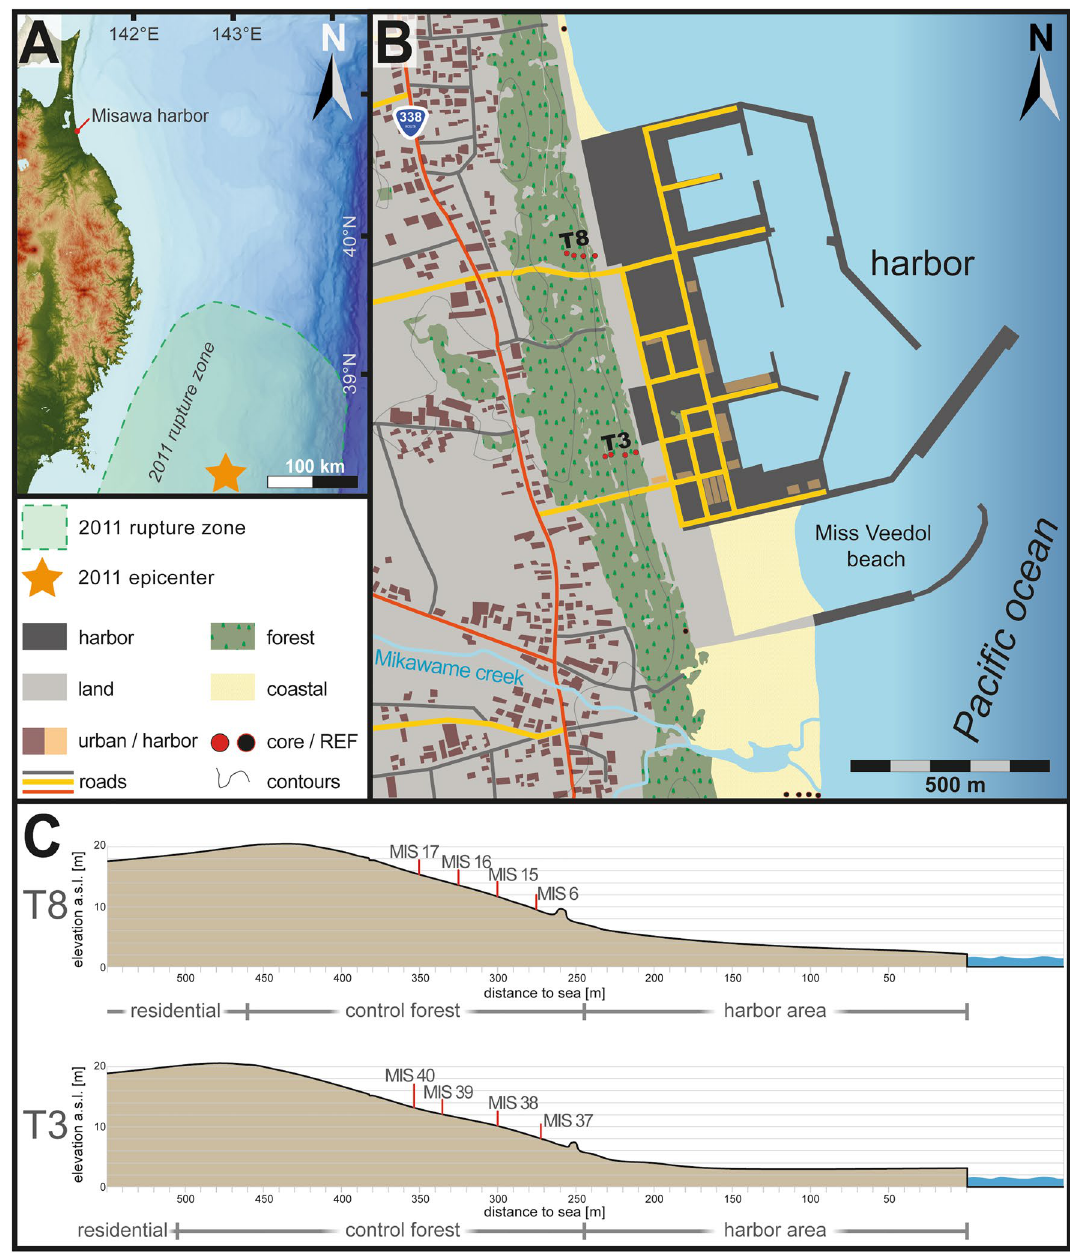
Figure 1. ( A ) Location of the study area in reference to the 2011 Tohoku-oki earthquake rupture zone 41 and epicenter 42 . ( B ) Study side of the Misawa harbor with the sample locations of transects T3 and T8 labelled by red dots and reference samples with black dots ( C ) Topographical profiles based on SRTM data for transects T3 and T8 with the location of each sampled Geoslicer. Maps and topographic profiles are based on open-access SRTM data (USGS EROS data through EarthExplorer; http:// earth explo rer. usgs. gov/), processed using ArcGIS Desktop 10.2 (ESRI) and illustrated Adobe Illustrator (Creative Cloud version 2020, https:// adobe. com/ produ cts/ illus